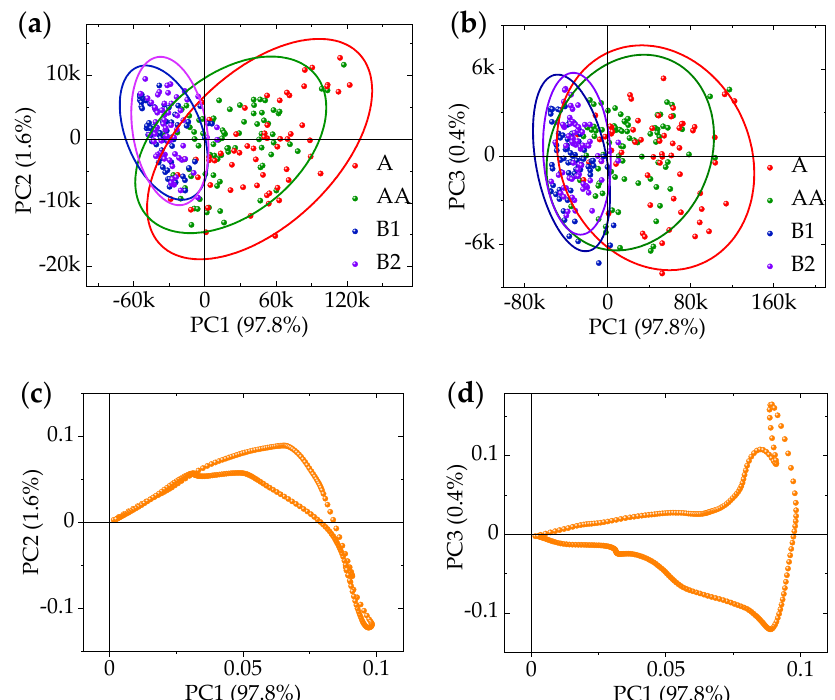
Figure 6. Principal components analysis (PCA) of 0° fiber light source based on Savitsky–Golay smoothing (SG) preprocessing. ( a ) Score plot of PC1-PC2; ( b ) Score plot of PC1-PC3; ( c ) Loading plot of PC1-PC2; ( d ) Loading plot of PC1-PC3.